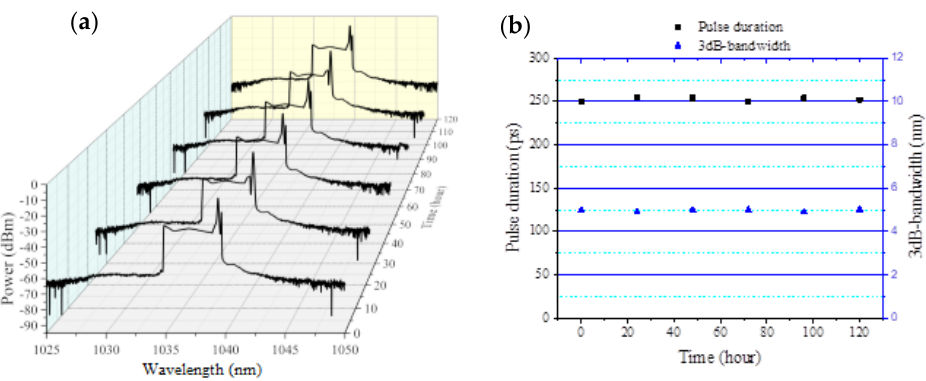
Figure 6. ( a ) Optical spectrum and pulse duration; ( b ) 3 dB bandwidth as a function of time.